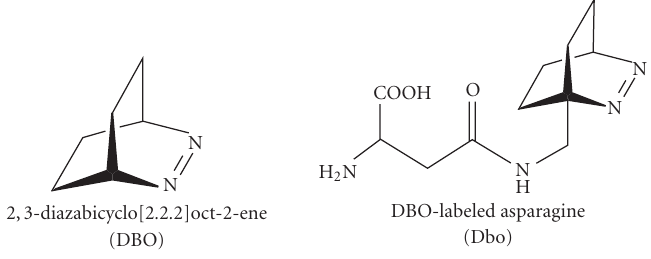
Scheme 2: Molecular structures of DBO and its asparagine derivative,